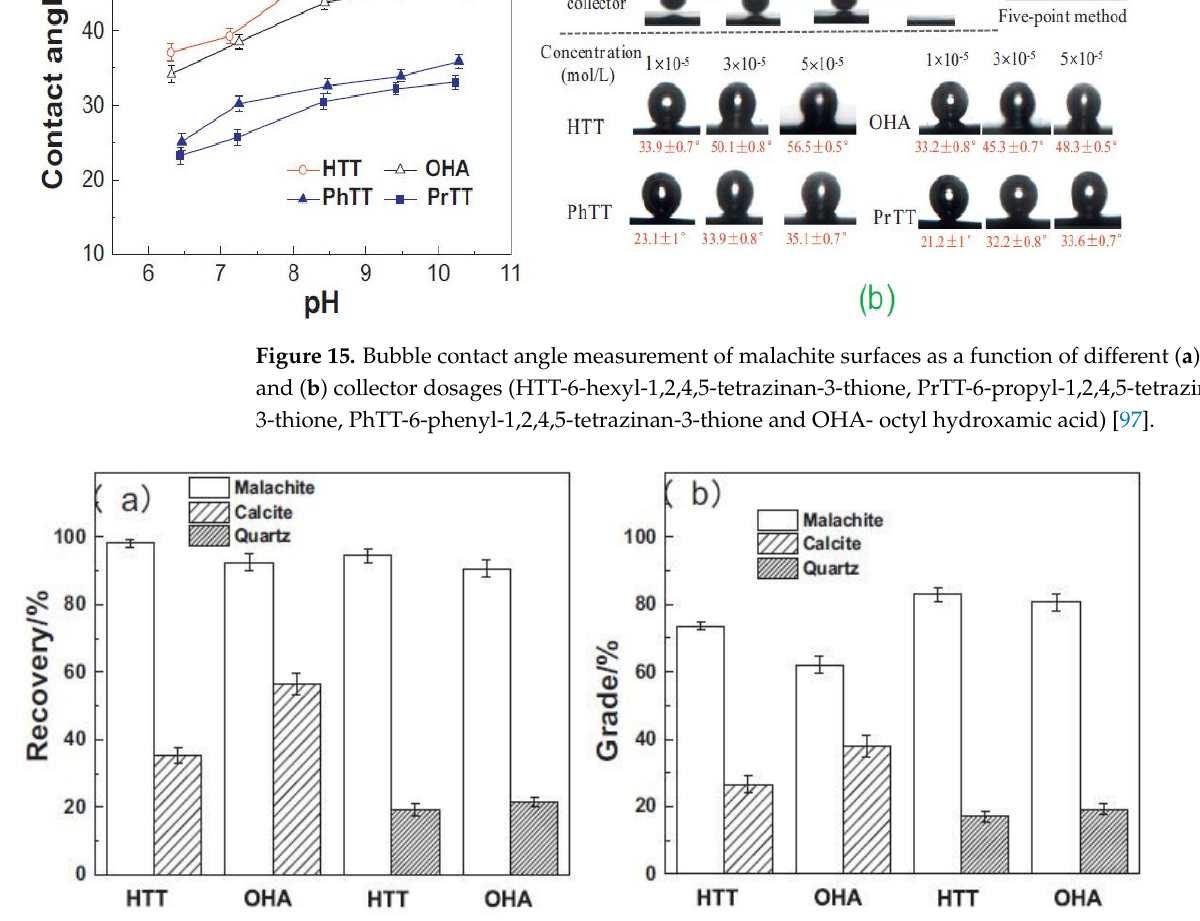
Figure 16. Flotation recovery ( a ) and grade ( b ) of malachite in the presence of different reagents (under 3 × 10 −5 mol·L −1 HTT (6-hexyl-1,2,4,5-tetrazinan-3-thione) and octyl hydroxamic acid (OHA) at pH ~9.4) [97].